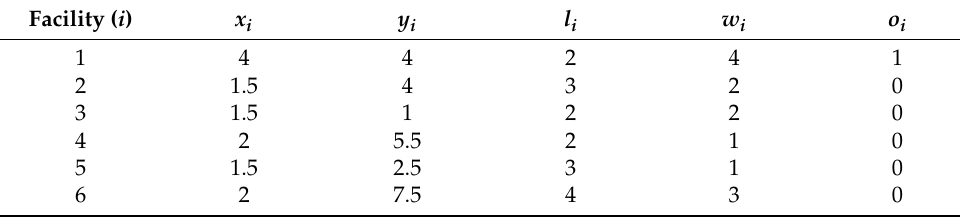
Table 2. Output data (optimal solution) for small UA-FLP